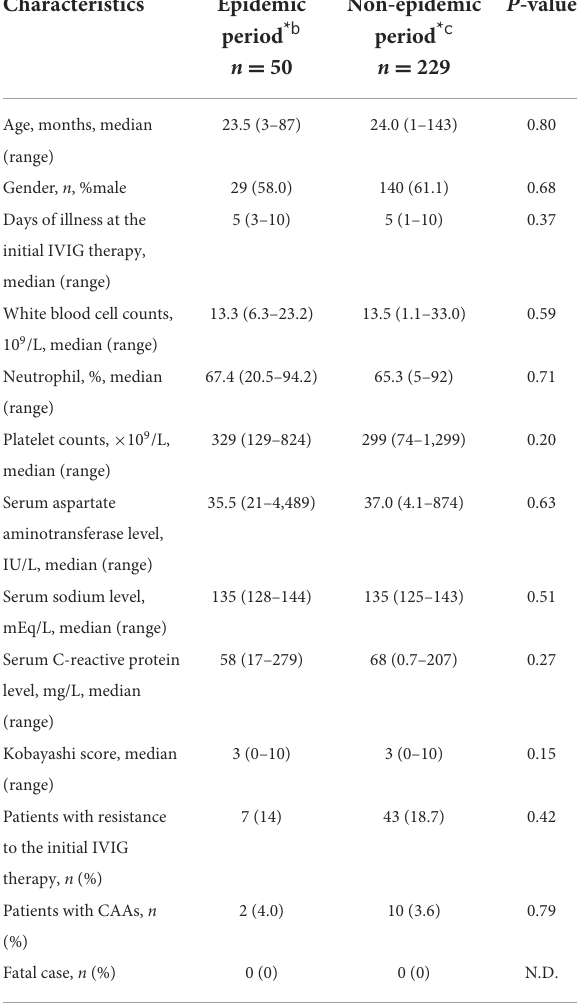
TABLE 4 The comparisons of the demographic and clinical characteristics between patients who developed KD during epidemic and non-epidemic periods in the years of large HFMD epidemics *a